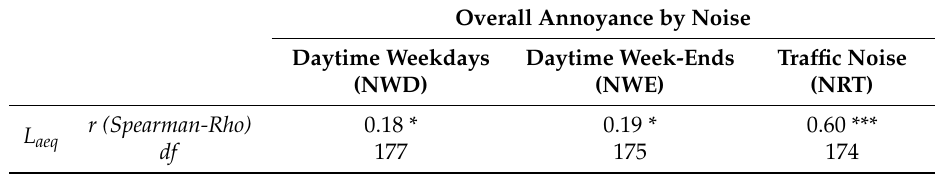
Table 5. Correlations of noise exposure ( L aeq ) and